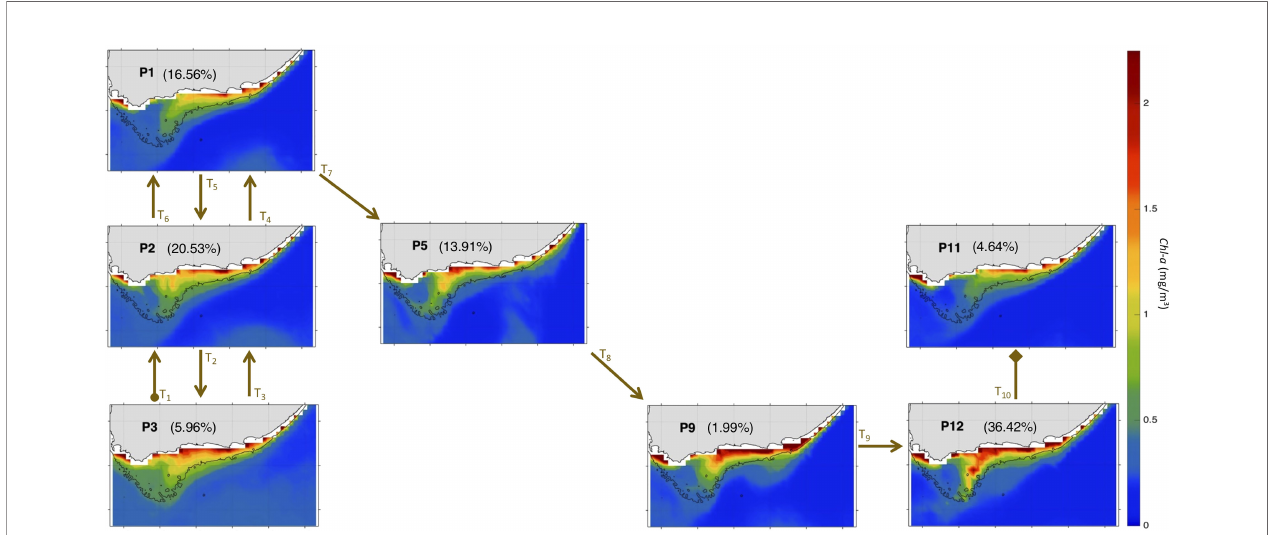
FIGURE 13 | Same as Figure 4 but for Nov-Mar 2010-11. The frequency of occurrence of each pattern is calculated here relative to the days recorded during Nov-Mar 2010-11. The brown arrows represent the SOM patterns trajectories (T i=1:10 ) evolving during Nov-Mar 2010-11 as inferred from the BMU timeseries ( Supplementary Figure 4A ). The starting ( fi nal) trajectory is designated with a circle (diamond) at the arrow beginning